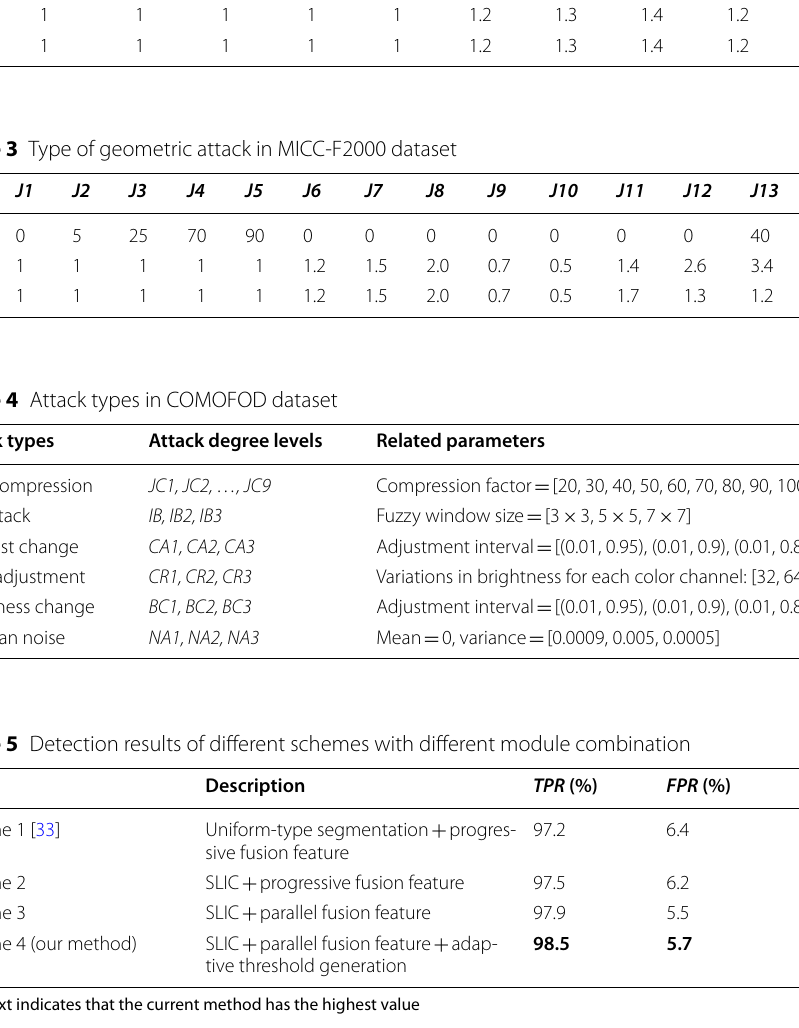
Bold text indicates that the current method has the highest